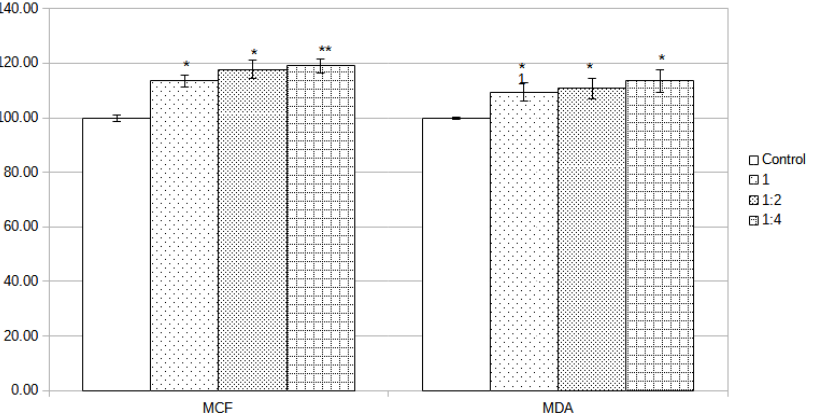
Figure 5. Viability of the MCF-7 and MDA-MB-231 cell lines as determined by MTT assay after 48 h of incubation with the tested extract in different dilutions: 1—concentrated extract, 1:2—1 part extract